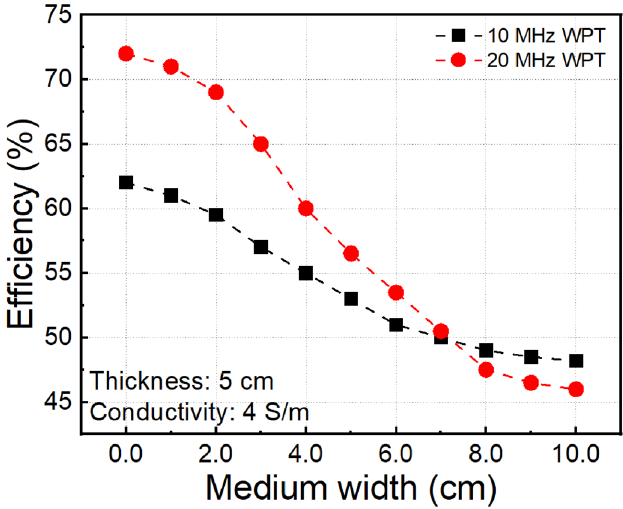
Figure 9. Measured transfer efficiency of two MR-WPT systems as a function of medium